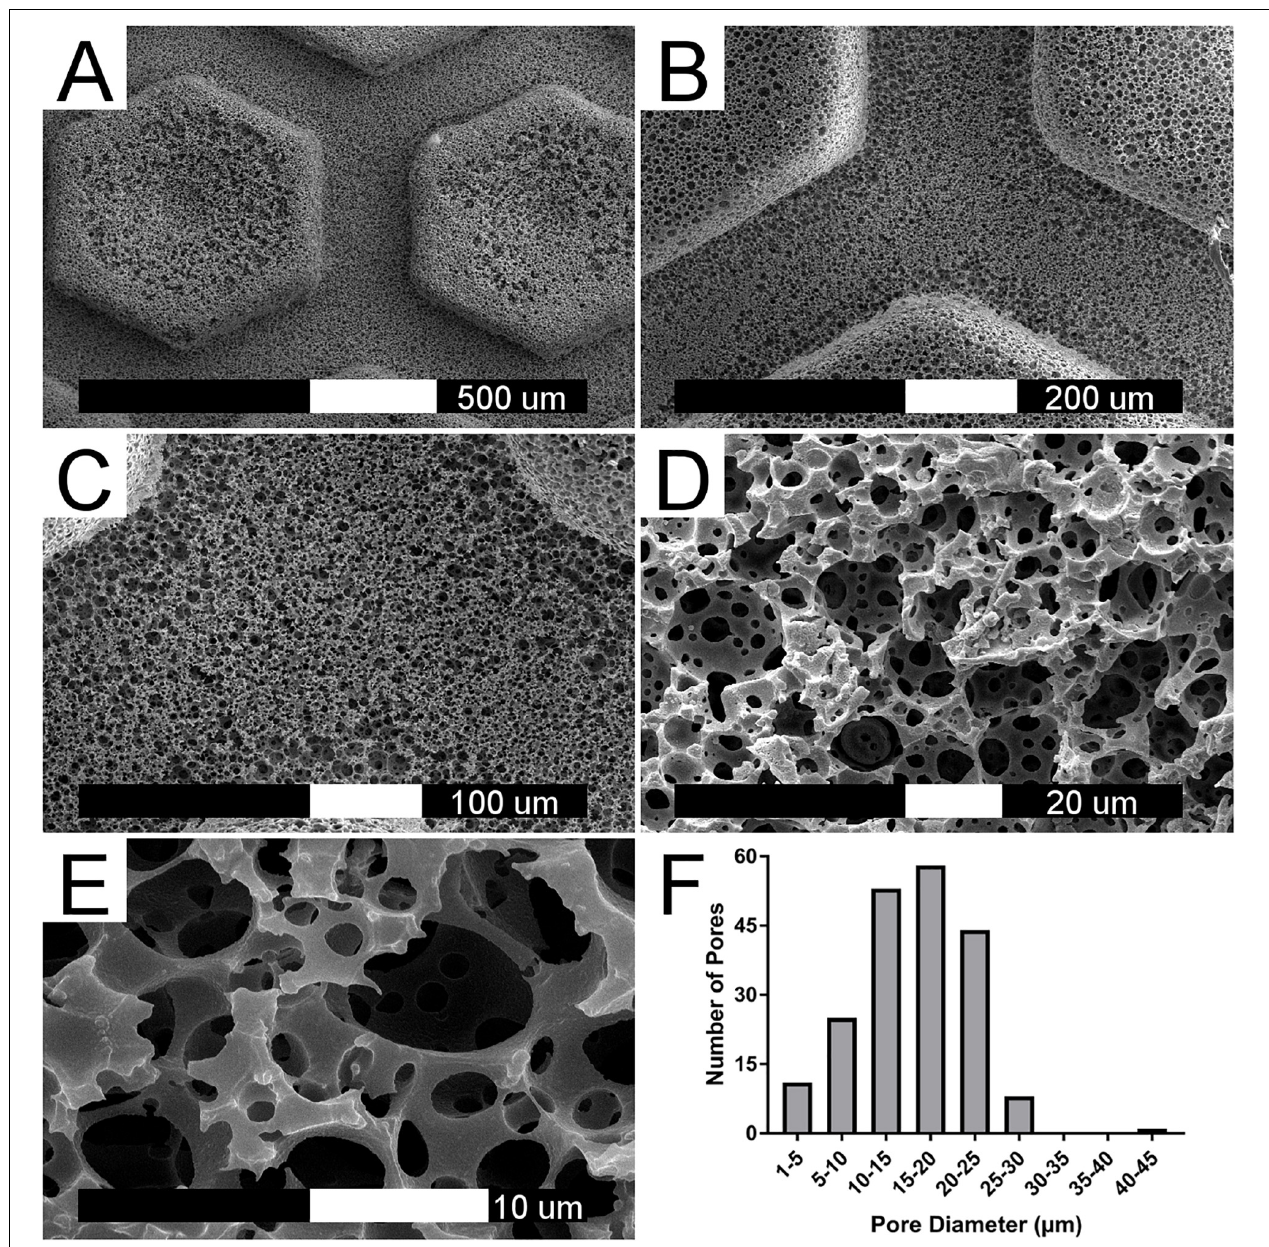
FIGURE 2 | PolyHIPE scaffold morphology. (A–E) SEM image of 80% porosity polyHIPE scaffold at increasing magnifications. (F) Histogram of pore diameter distribution based on eight different SEM image analysis ( n = 200).